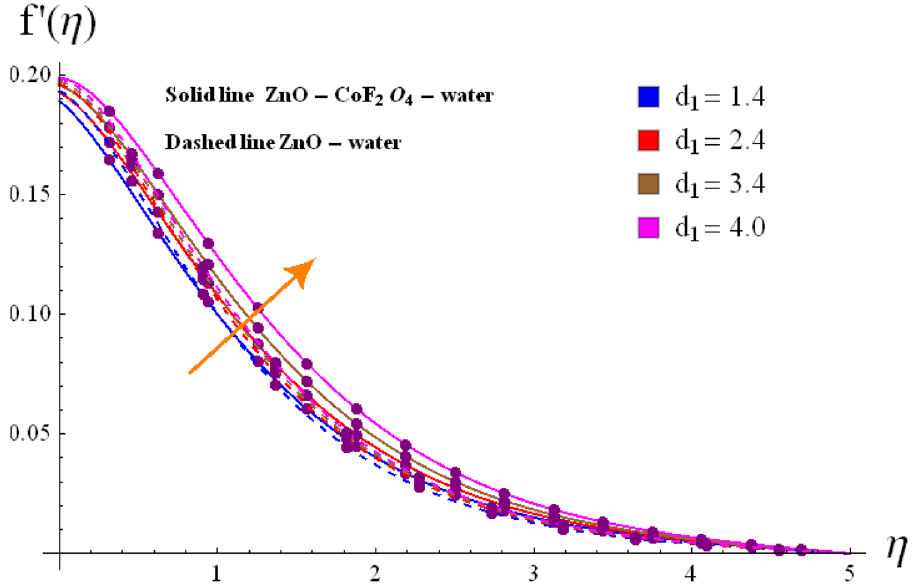
Figure 5. Variation of f ′ (η) via d 1